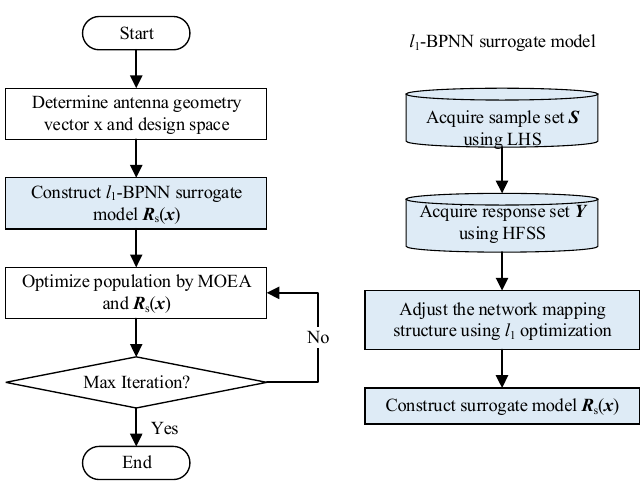
Figure 7. Flowchart of the fast multi-objective antenna optimization framework combining the l 1 -BPNN surrogate model and MOEAs.